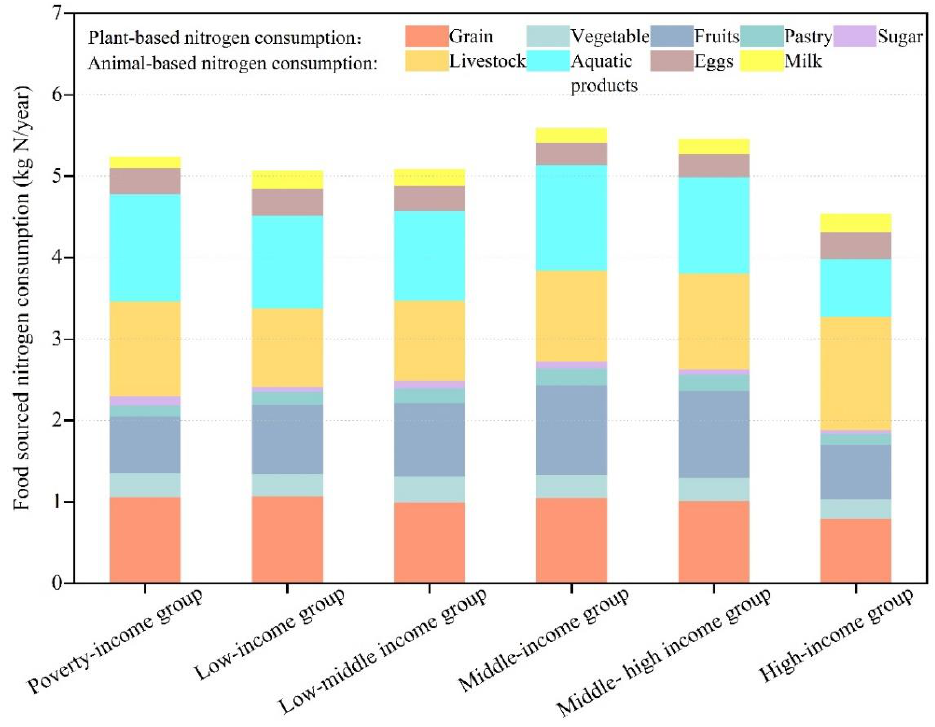
Figure 4. Per capita food-sourced nitrogen consumption for the six household groups.